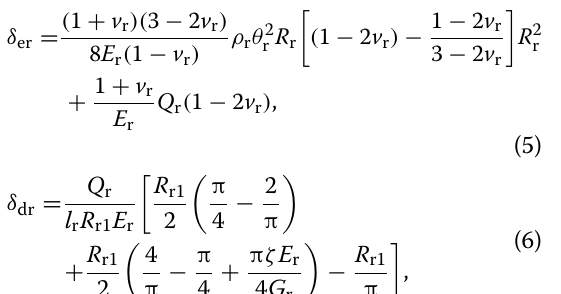
the contact area between the roller and inner/outer races, outer race, respectively; l r is the equivalent length of the roller; E e and v are the equivalent elastic modulus and Poisson’s ratio, respectively; R i and R r are the radii of the inner race and roller, respectively.